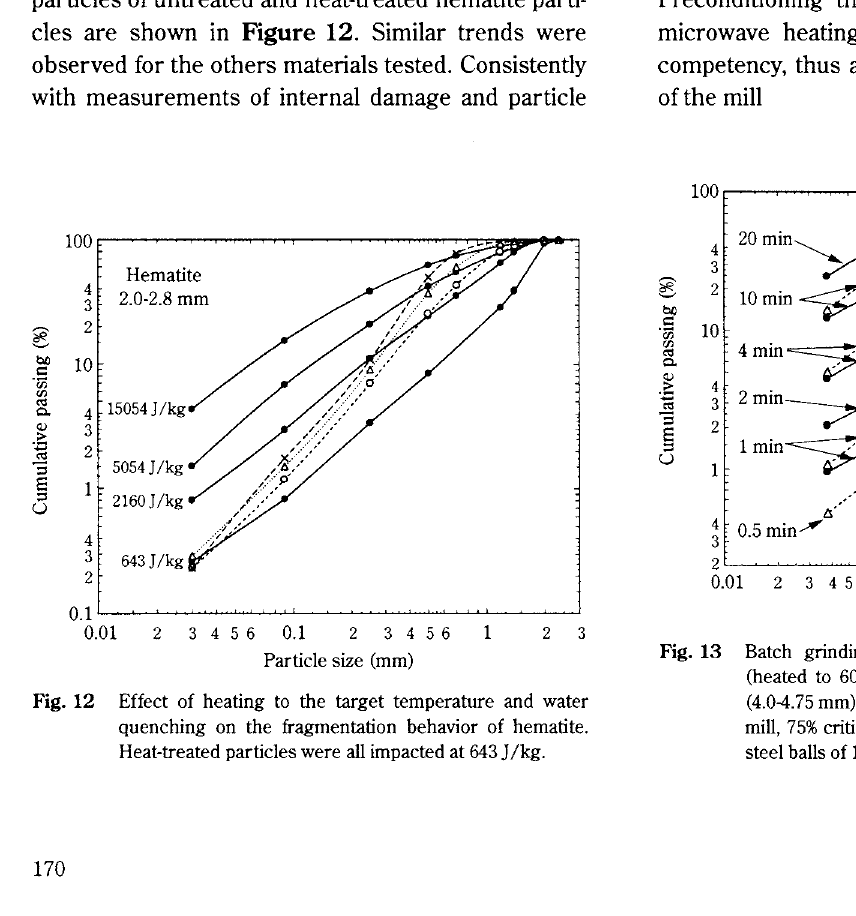
Fig. 12 Effect of heating to the target temperature and water quenching on the fragmentation behavior of hematite. Heat-treated particles were all impacted at 643 J /kg.